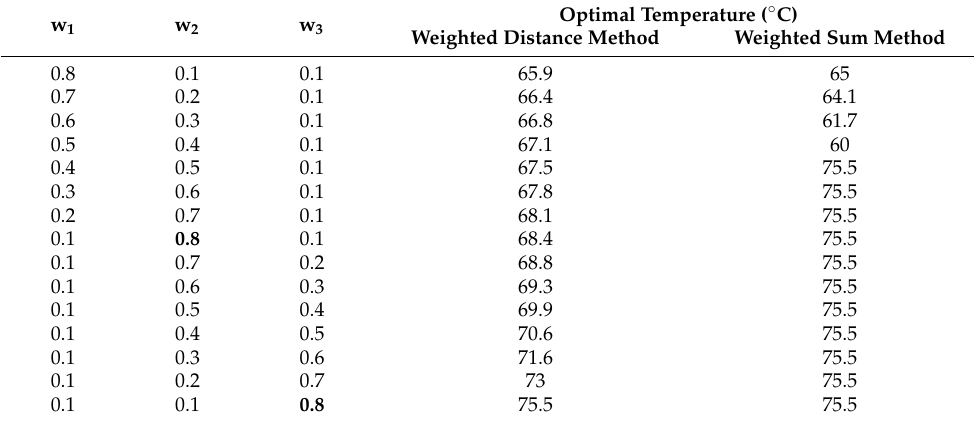
Table 5. Simulated sweep along the weight’s